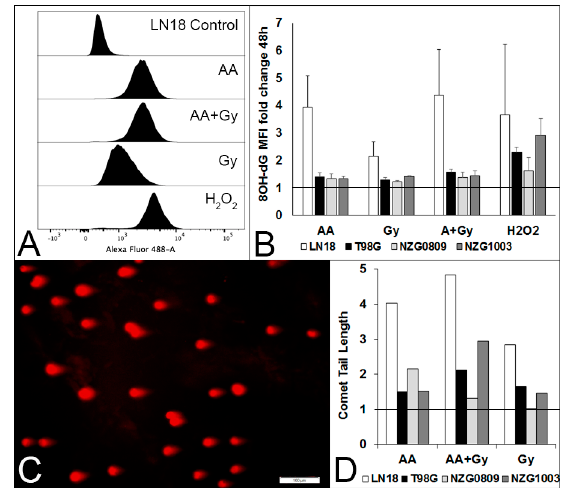
Figure 2. Different types of DNA damage after a 1 h exposure to 5 mM AA, 6 Gy, 5 mM AA + 6 Gy and 500 µM H 2 O 2 . ( A ) Histograms of 8OH-dG lesions 48 h after treatments of LN18 cells. ( B ) Median fluorescence intensity (MFI) fold change compared with untreated cells of LN18, T98G, NZG0809 and NZG1003 cells. Values are averages ± SEM of at least 3 independent experiments in triplicate. Increased 8OH-dG lesions for H 2 O 2 treatment over AA, Gy and AA + Gy was statistically significant ( p < 0.05: unpaired two-tailed student t -test) for T98G and NZG1003. C. Representative photograph of comet tails (DSBs) of LN18 cells after a 1 h exposure to 5 mM AA. D. Fold change compared with controls of comet tail length of the different cell lines after a 1 h exposure to 5 mM AA, 6 Gy, 5 mM AA + 6 Gy compared to untreated controls (set at 1). Average number of comet tails measured per cell line: 278 (controls), 162 (AA), 220 (Gy) and 272 (AA + Gy).